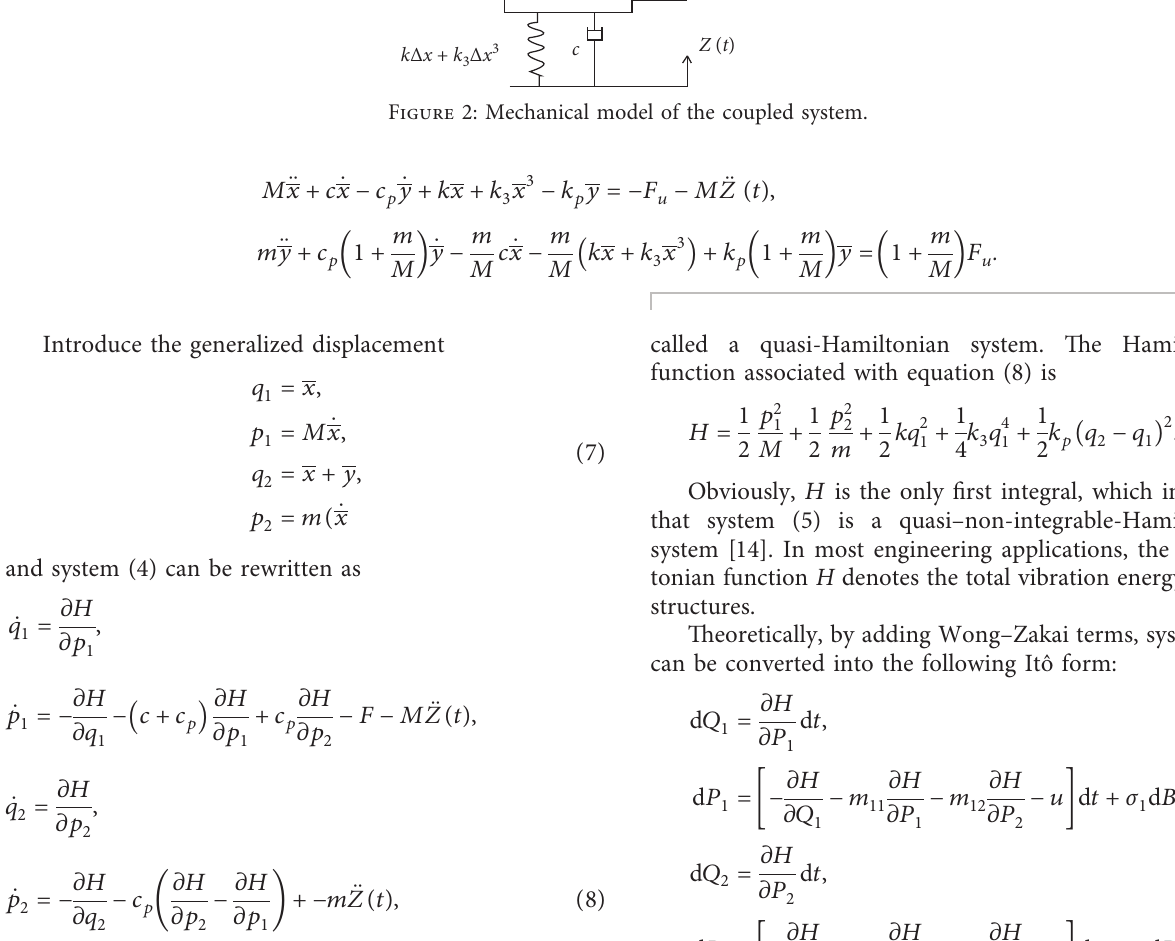
Piezoelectric stack actuator